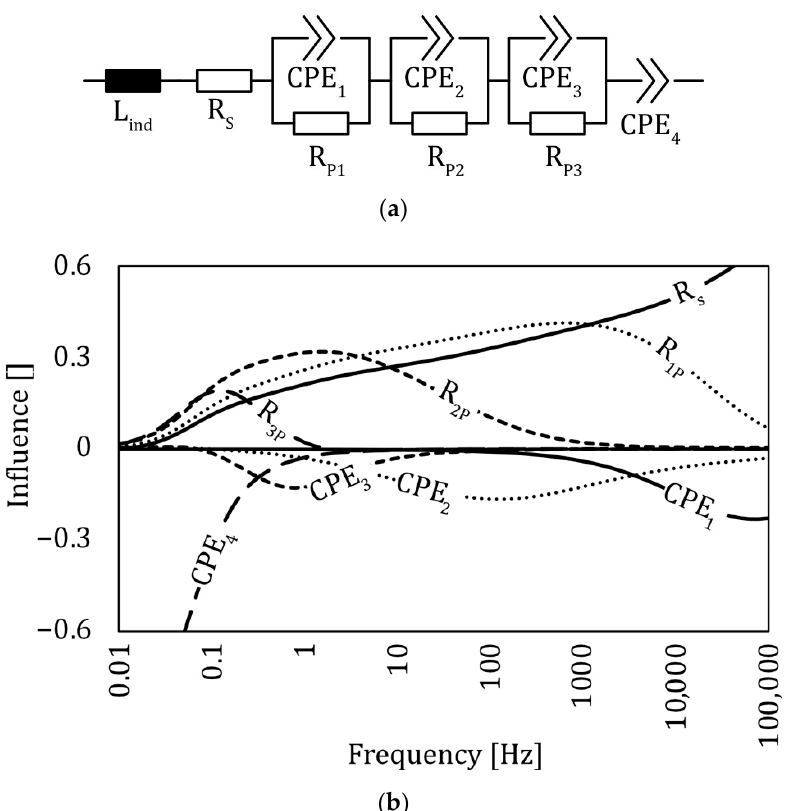
Figure 2. Equivalent circuit model with corresponding influence plot ( a ) Equivalent circuit used to fit the measured data to elements describing the supercapacitor. ( b ) Influence of the elements used on the equivalent circuit in relation to the excitation frequency. Each element has a frequency depended influence on the whole impedance of the supercapacitor. e.g., CPE1 leads to a greater change in impedance at high frequencies compared to CPE4. Negative influence means it is reducing the impedance, positive influence increases the impedance. Influence is a dimensionless